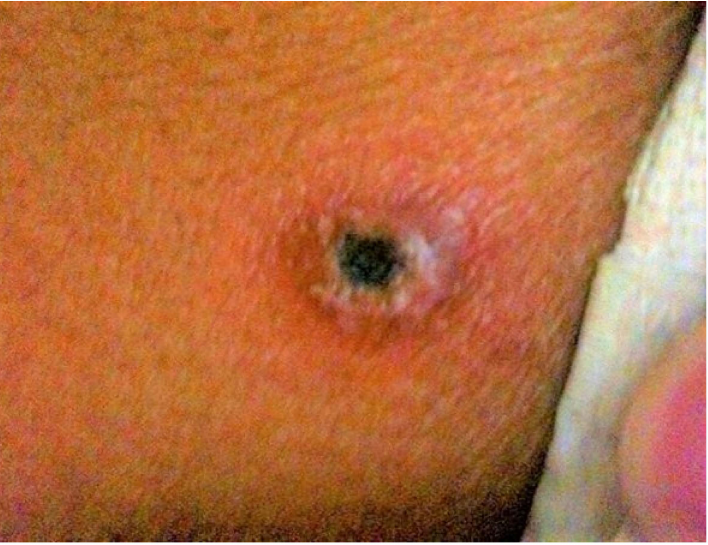
Figure 1. Eschar on the back of a patient with scrub typhus. Unidentified patient photo from Thundon Ngamprasertchai,